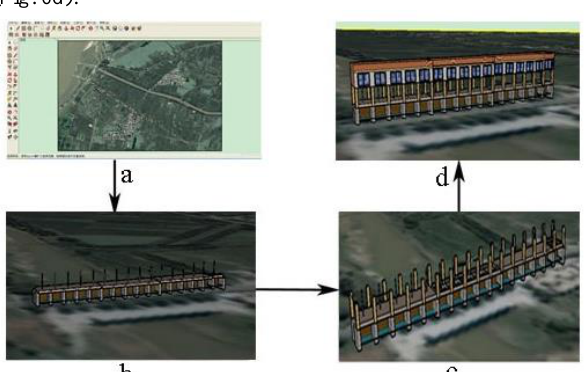
Fig.6 Building ground feature 3D model by using interactive modeling method